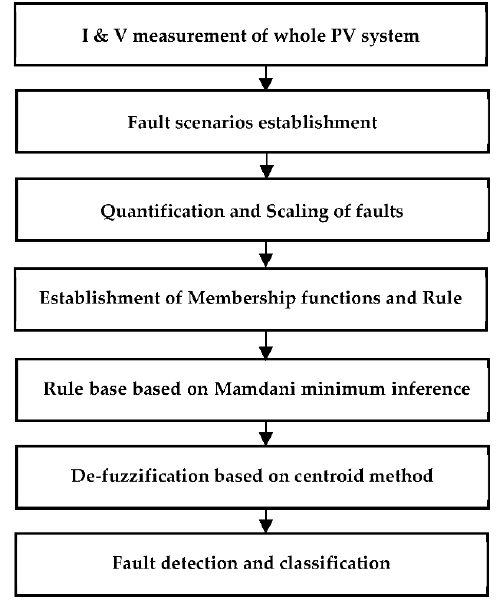
Table 3. PV array block parameters (Ningbo solar electric power (Mono)).